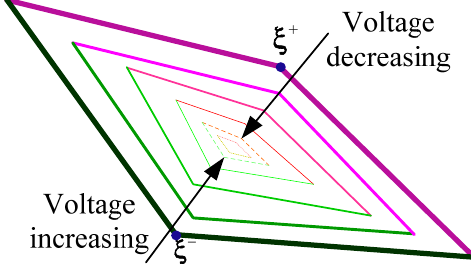
Figure 2. Voltage distribution in the proposed voltage security region.